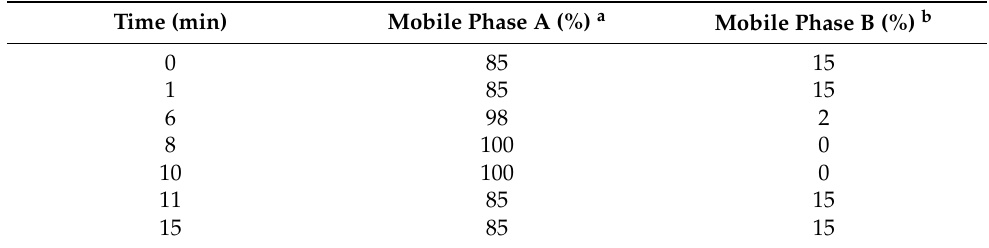
Table 1. Gradient program of the Ultra High Performance Liquid Chromatography (UHPLC) method.